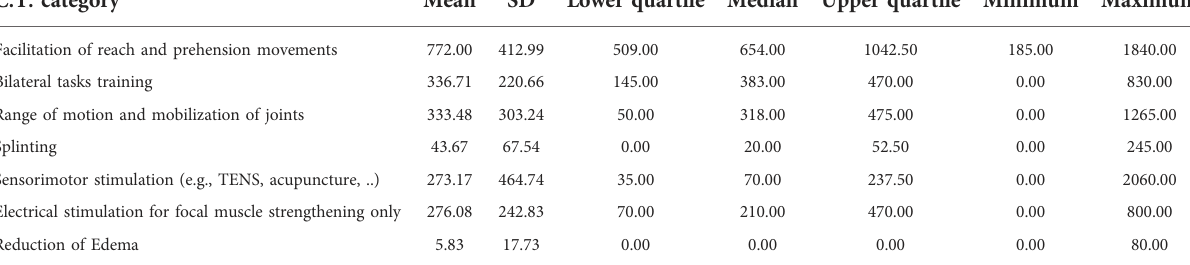
TABLE 4 Summary of total time (minutes) spent in each C.T.